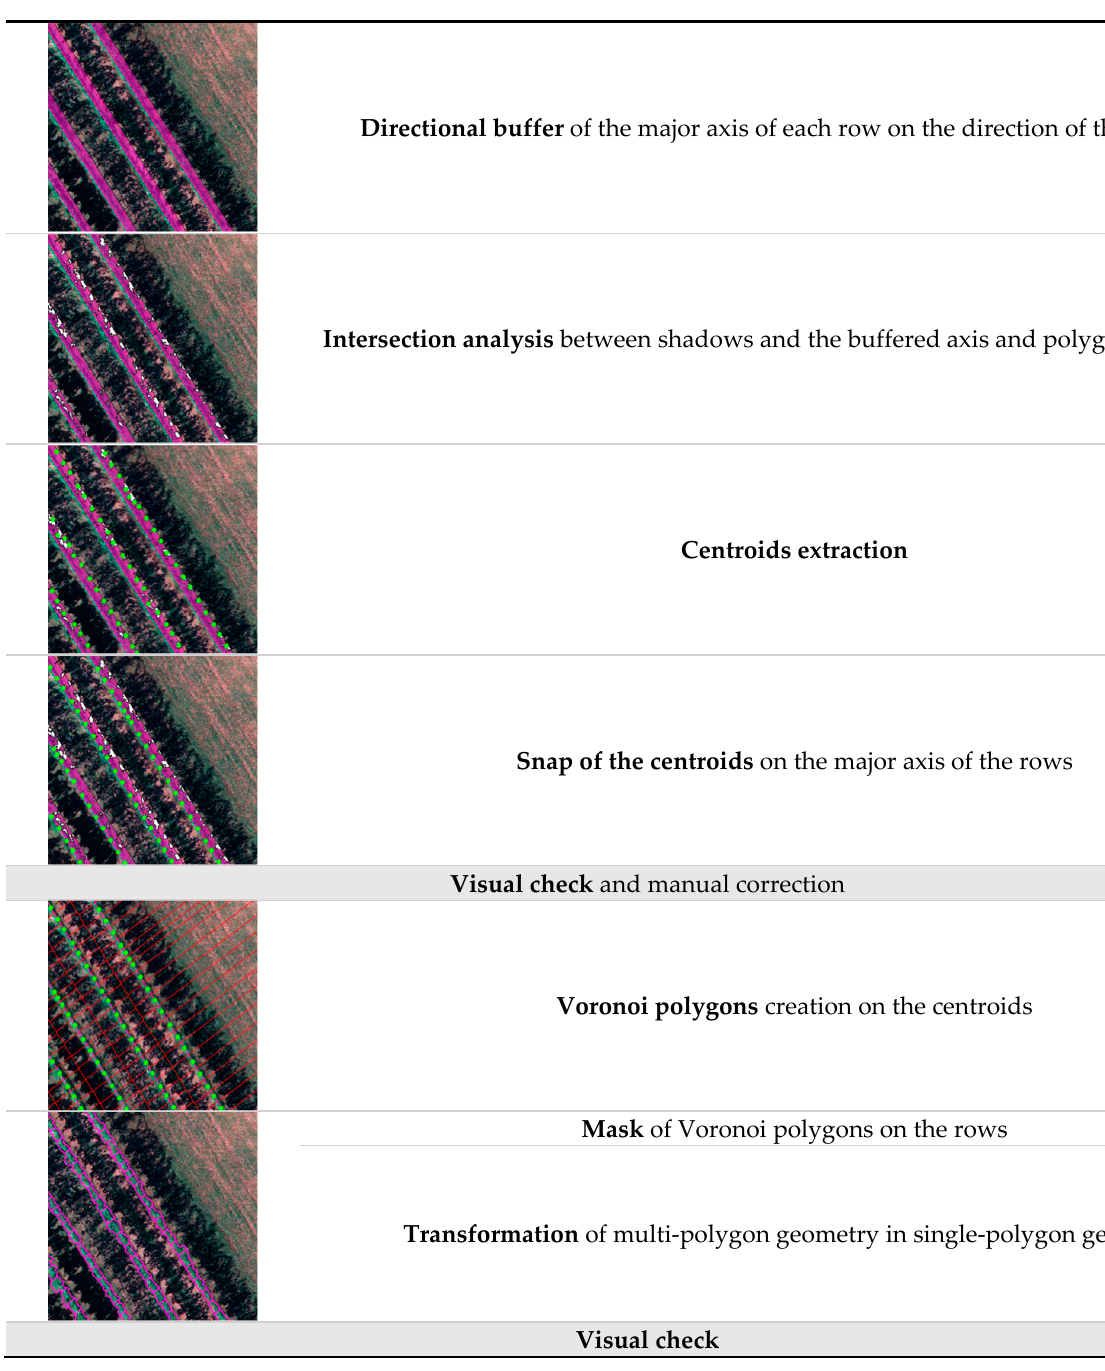
Figure 6. Workflow for the detection of the single